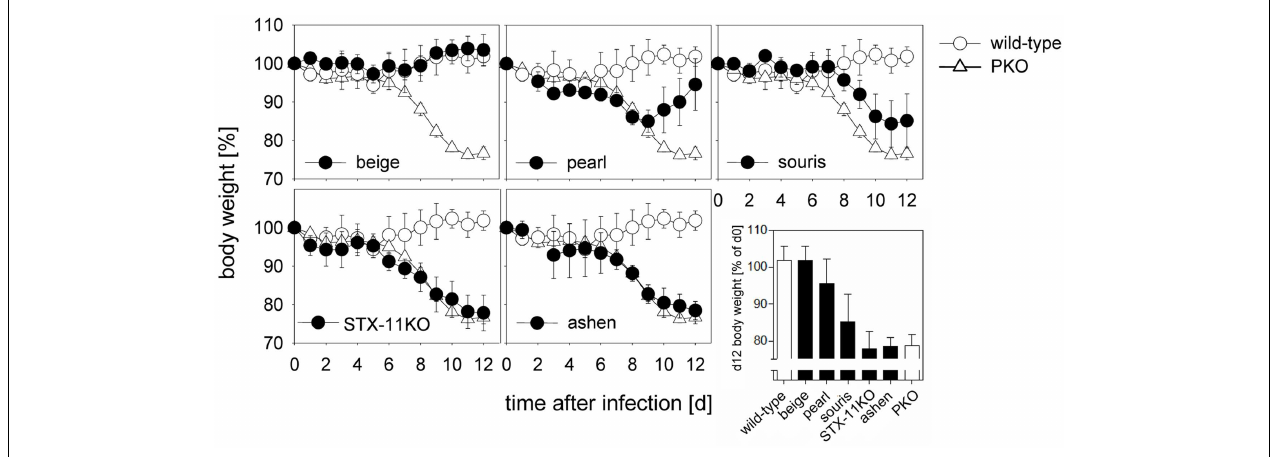
pearl , souris , STX-11KO , ashen /filled circles) in comparison with wild-type (open circle) and PKO (open triangle) mice are shown.The graph depicted on the lower right illustrates a direct comparison of body weight loss of all mouse groups on day 12 after LCMV